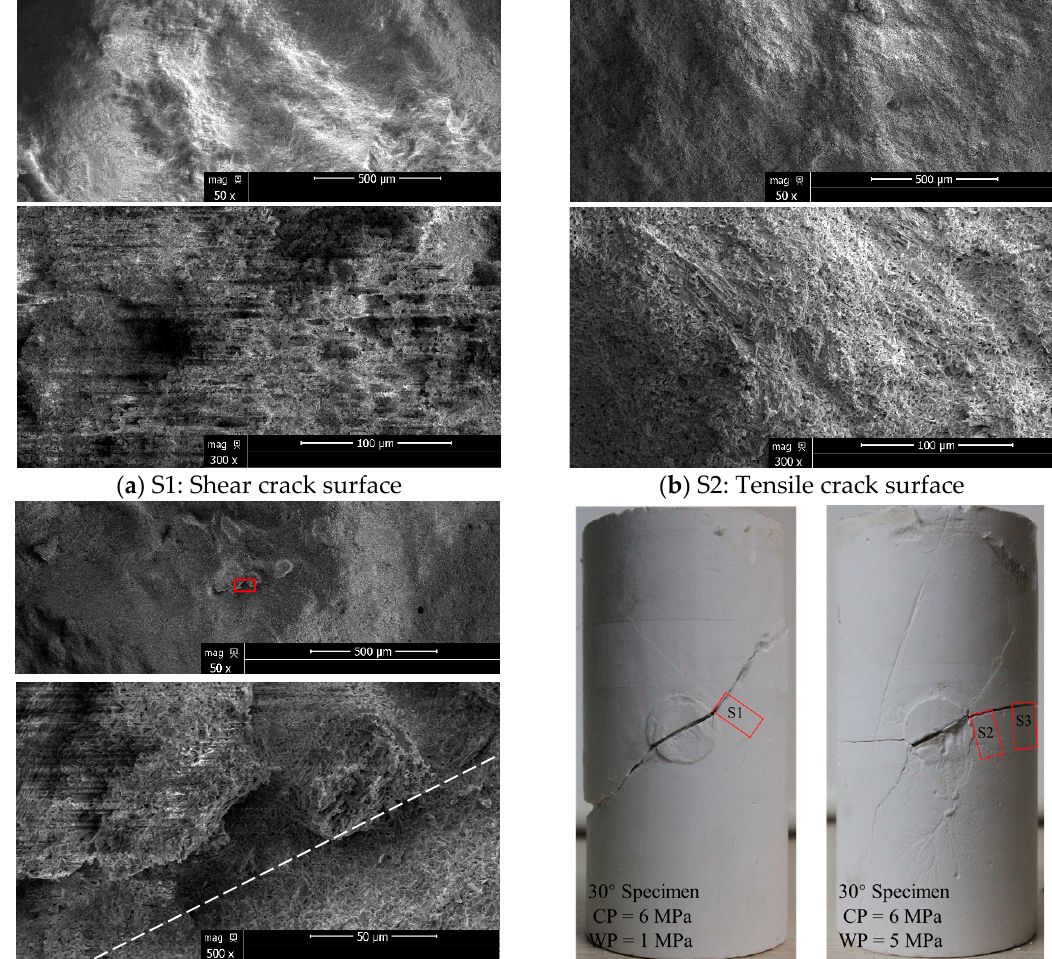
Figure 12. Scanning electron microscope (SEM) scanning images of shear, tensile, and mixed cracks.